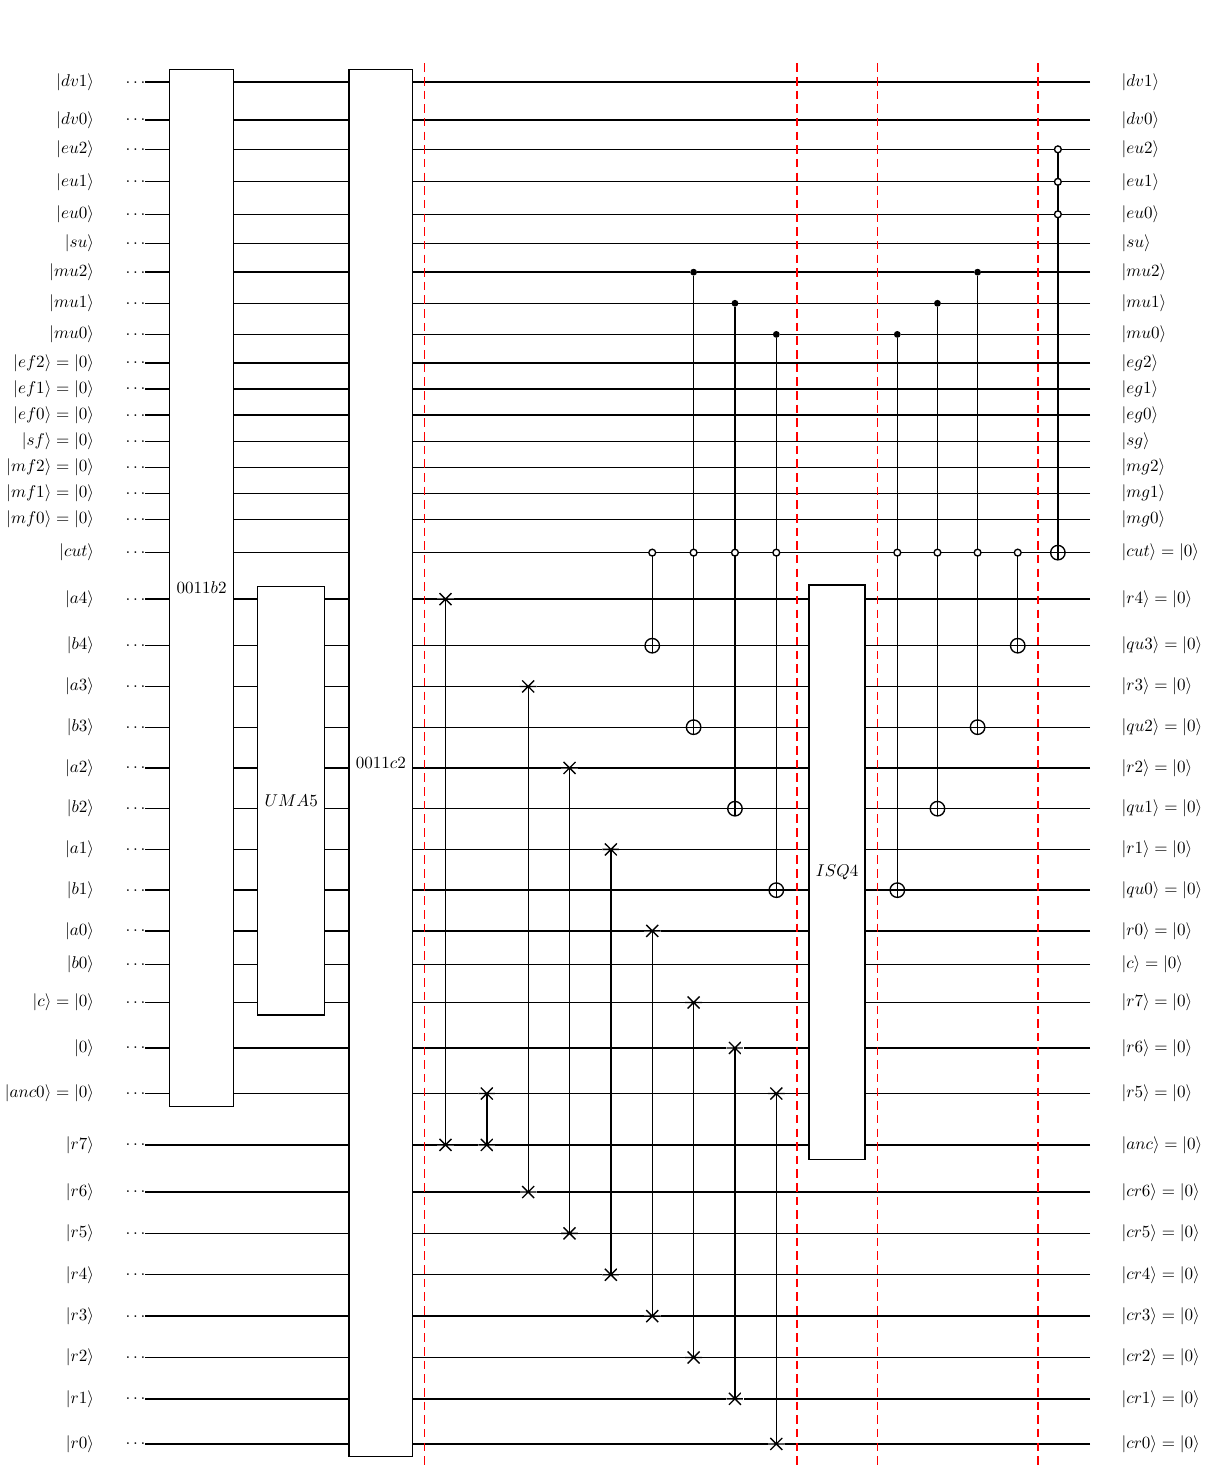
Figure 7. Quasi-1D Burgers: quantum circuit design for the evaluation of (cid:126) f eq in the lattice model. The floating-point representation uses four mantissa qubits ( N M = 4) and three exponent qubits ( N E = 3), with an exponent bias set to five. Part